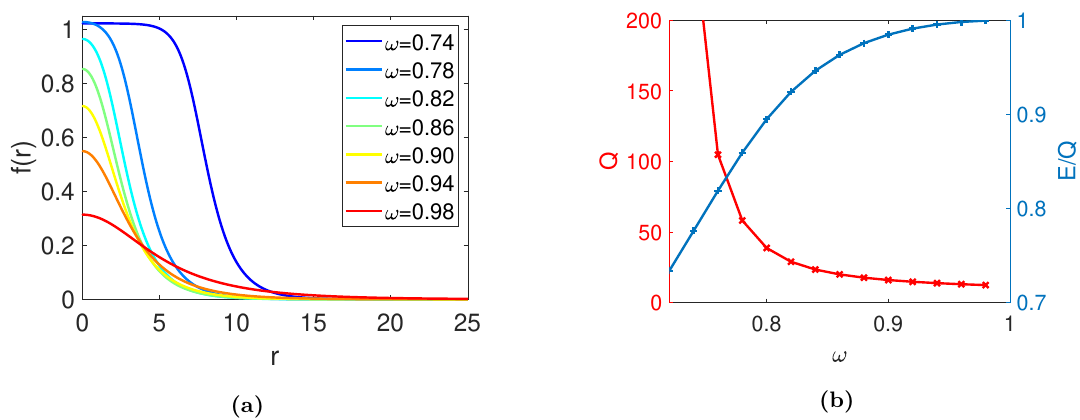
Figure 1. Profiles (left plot), total charges and ratios of total charge to total energy (right plot) of elementary Q-balls with different frequencies for potential (2.3). The fact that E/Q < 1 ensures the stability of elementary Q-balls. Dimensionful quantities are in units of the scalar mass m